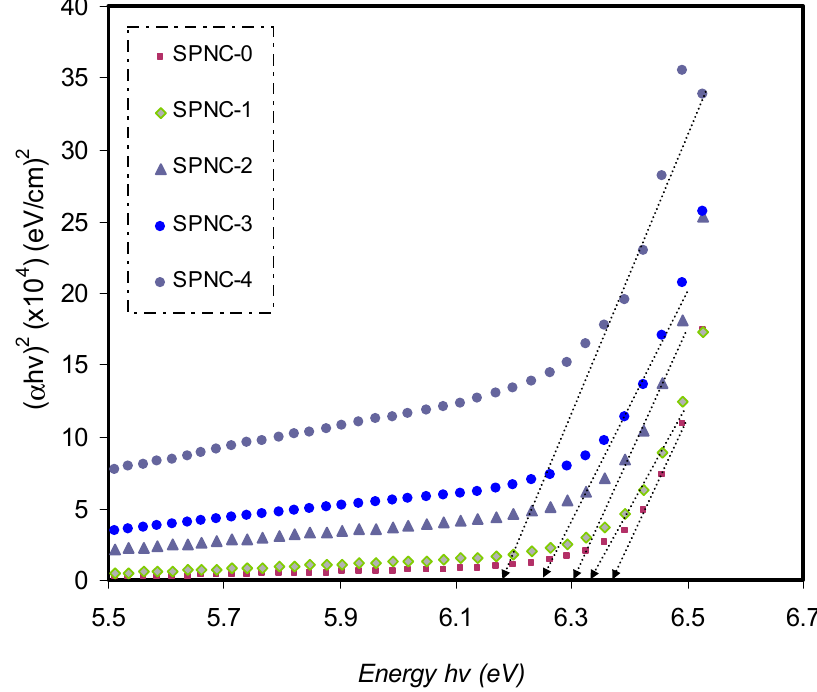
Figure 10. The plots of ( α h υ ) 2 versus ( h υ ) for pure PVA and PVA-doped samples.